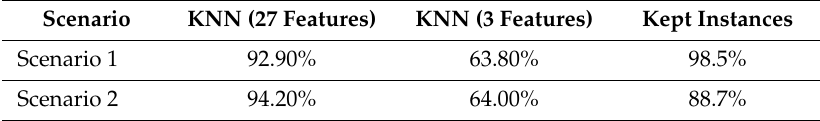
Table 7. F-measure value with di ff erent cleansing levels and di ff erent amount of